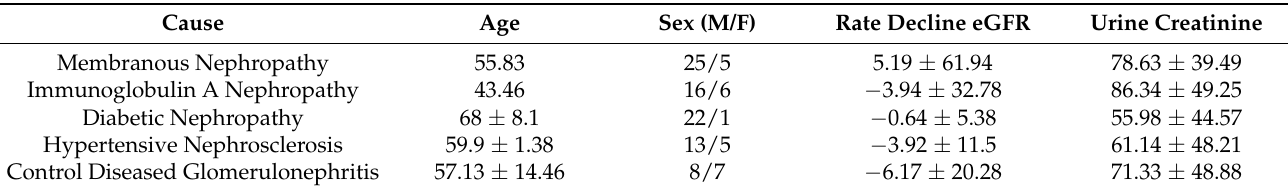
Table 3. Characteristics of study